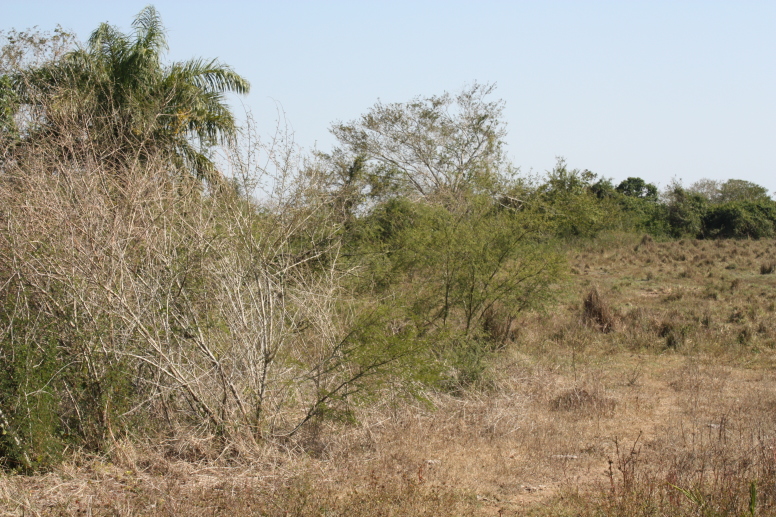
Brachypelma
kahlenbergi habitat, human-disturbed scrub and pasture near Veracruz, Veracruz state, Mexico. Photo: Stuart J. Longhorn.